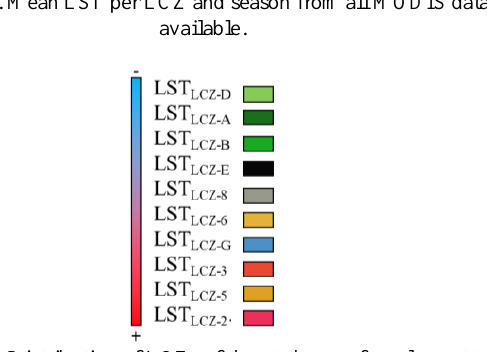
Figure 9 . Distribution of LCZs of the study area from lowest to highest LST.